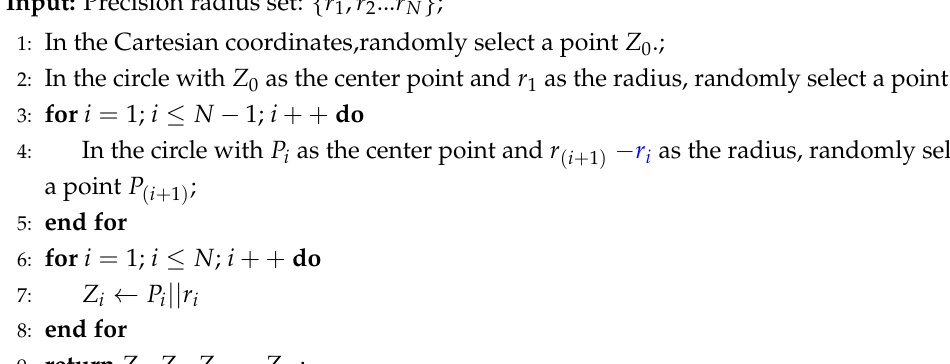
Figure 3. Virtual location data. Algorithm 1 Initialization: pseudocode for randomly generating the virtual location